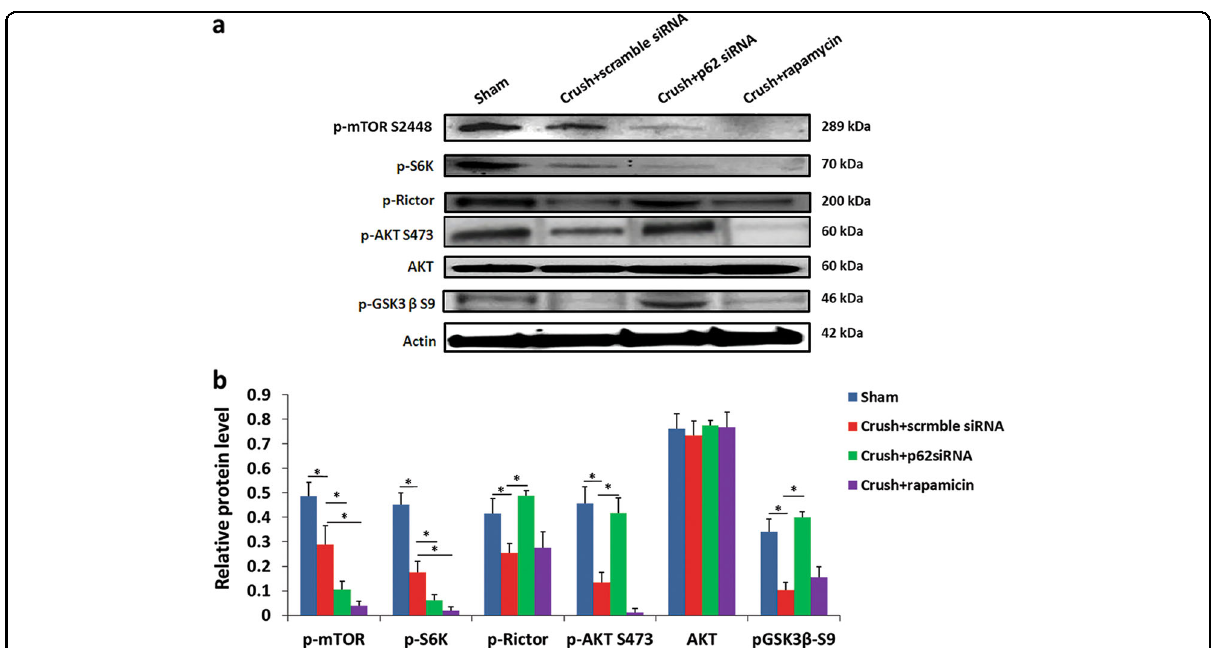
Fig. 5 Regulation of mTOR C1 and mTOR C2 activation in the retina after autophagy inducer treatment. a Western blotting of the expression levels of p-mTOR, p-S6K, p-Rictor, p-Akt S473, Akt, and p-GSK3 β in each group. Representative results from three independent experiments are shown. b Quantitative analysis of the levels of p-mTOR, p-S6K, p-Rictor, p-Akt S473, Akt, and p-GSK3 β normalized to the internal control, β -actin. * P <